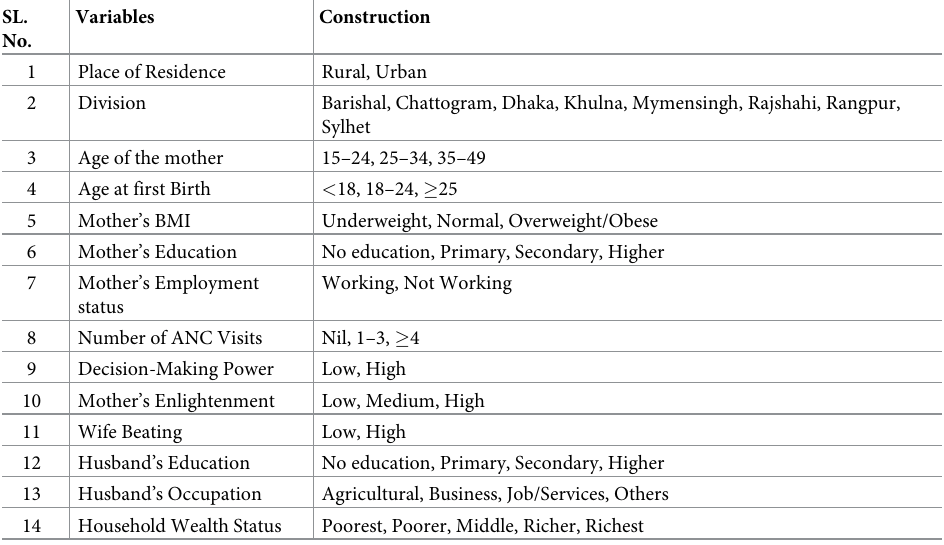
Table 1. Description of the explanation variables along with their categories. SL.